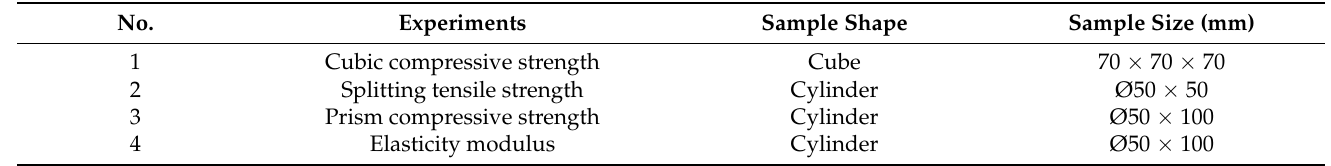
Figure 4. Mineral composition of ATWR. (Q 1 represents the early stage of quartz, and Q 2 repre ‐ sents the late stage of quartz.) Table 2. Dimensions of the specimens for rock mechanical